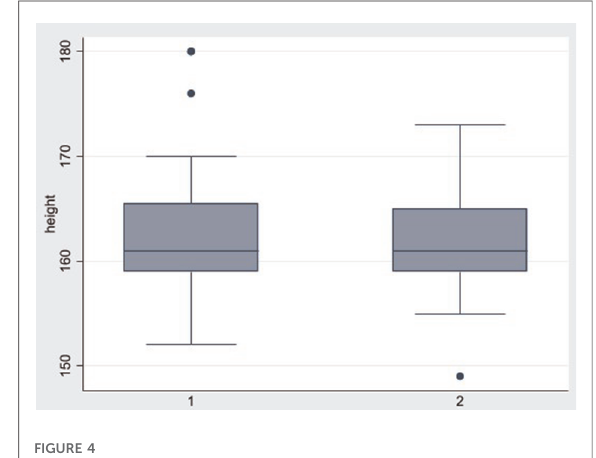
FIGURE 4 Boxplot height across groups.